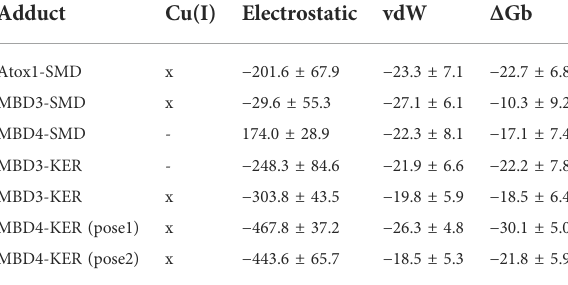
TABLE 1 Binding free energy ( Δ Gb, kcal/mol) of the SMD and KER peptides to Atox1 and MBD 3/4 of ATP7B, respectively, obtained with the Molecular Mechanics/Generalized Born Surface Area (MM- GBSA) method. The electrostatic and Van der Waals components of the binding free energy are reported. Cu(I) indicates whether the protein is simulated in the presence (x) or absence (-) of a bound Cu(I)ion.Standarddeviationisreported.Inthistable,onlythe Δ Gb of the peptide/target models that were stable during molecular dynamics simulations are reported. A complete list of all models built and simulated is reported in Supplementary Table